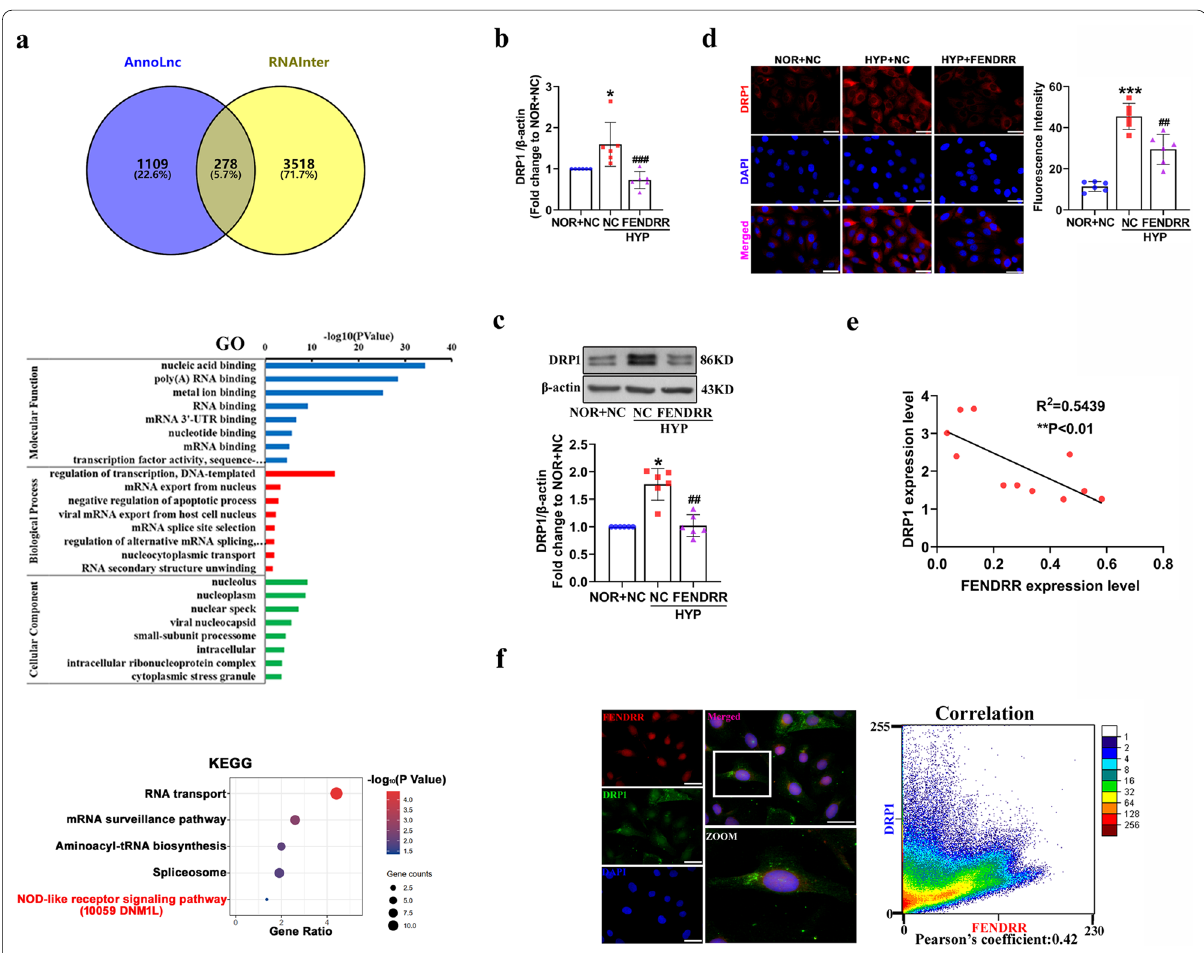
Fig. 3 DRP1 is regulated by FENDRR in HPAECs. a AnnoLnc and RNAInter bioinformatics software predicted FENDRR target proteins, and Gene Ontology (GO) and Kyoto Gene and Genomic Encyclopedia (KEGG) analysis of 278 genes in intersection. b Expression of DRP1 quantified by qRT-PCR (n 5). c Western blot was used to verify the expression of DRP1 (n 5). d Fluorescence staining for DRP1. HPAECs were stained for = = DRP1 (red) and DAPI (blue) was used for nuclear staining. Scale bar 50 μm. e Analysis of the correlation between FENDRR and DRP1 in HPAECs. f = Colocalization of FENDRR and DRP1in HPAECs. Scale bars 50 µm. FENDRR probes were labeled with Cy3 (red), DRP1 were stained with FITC (green) = and nuclei were stained with DAPI (blue). Pearson coefficient is 0.42, indicating no correlation. Each datapoint in the figure represents a unique biological replicate. All values are presented as the mean SD. Statistical analysis was performed with one-way ANOVA. NOR: normoxic; HYP: ± hypoxic; NC: negative control. *P < 0.05, **P < 0.01, ***P < 0.001 compared with